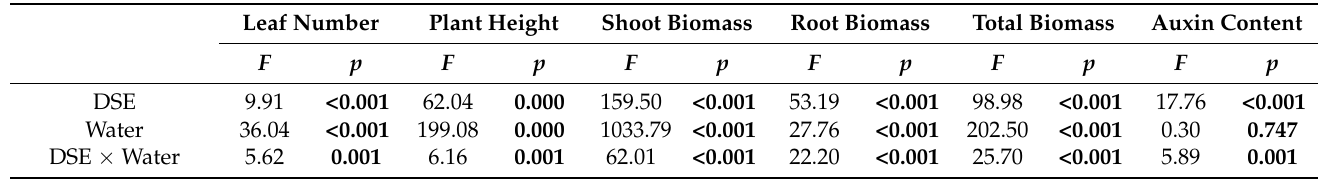
Table 1. The influences of DSE (DSE) and water (Water) treatments on the growth parameters of wheat seedlings based on two-way analysis of variance